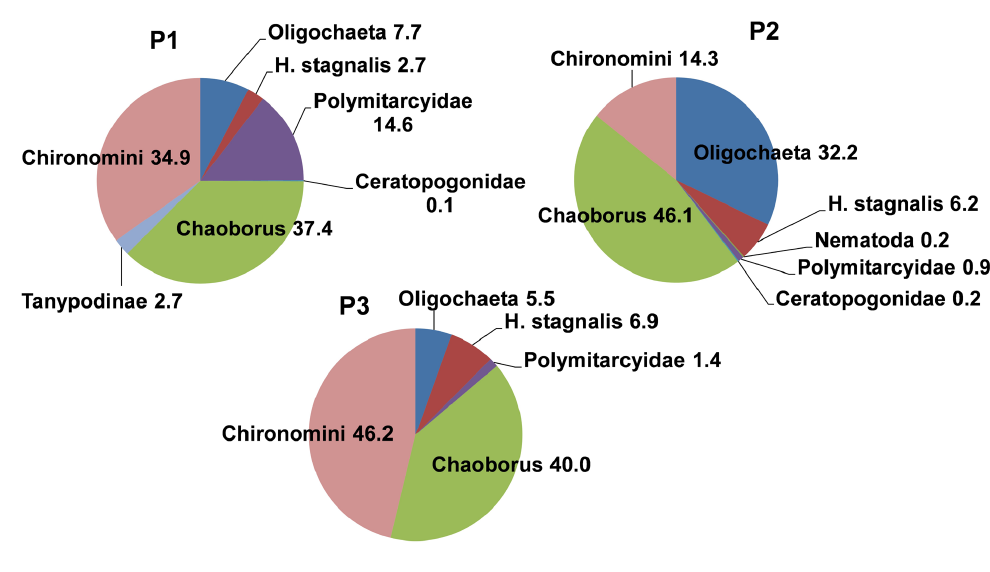
Figure 4. Relative abundances (%) of benthic macroinvertebrates by sampling site (P1 - Taquacetuba, P2 - Alvarenga and P3 - Biguás Island) at Billings Reservoir (Brazil, São Paulo State).